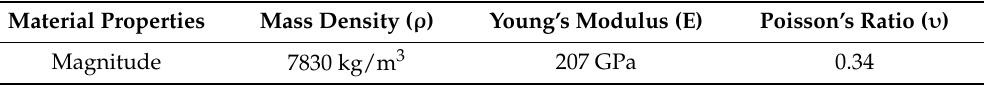
Table 3. Material properties used in the FE model of rigid plate and bodies